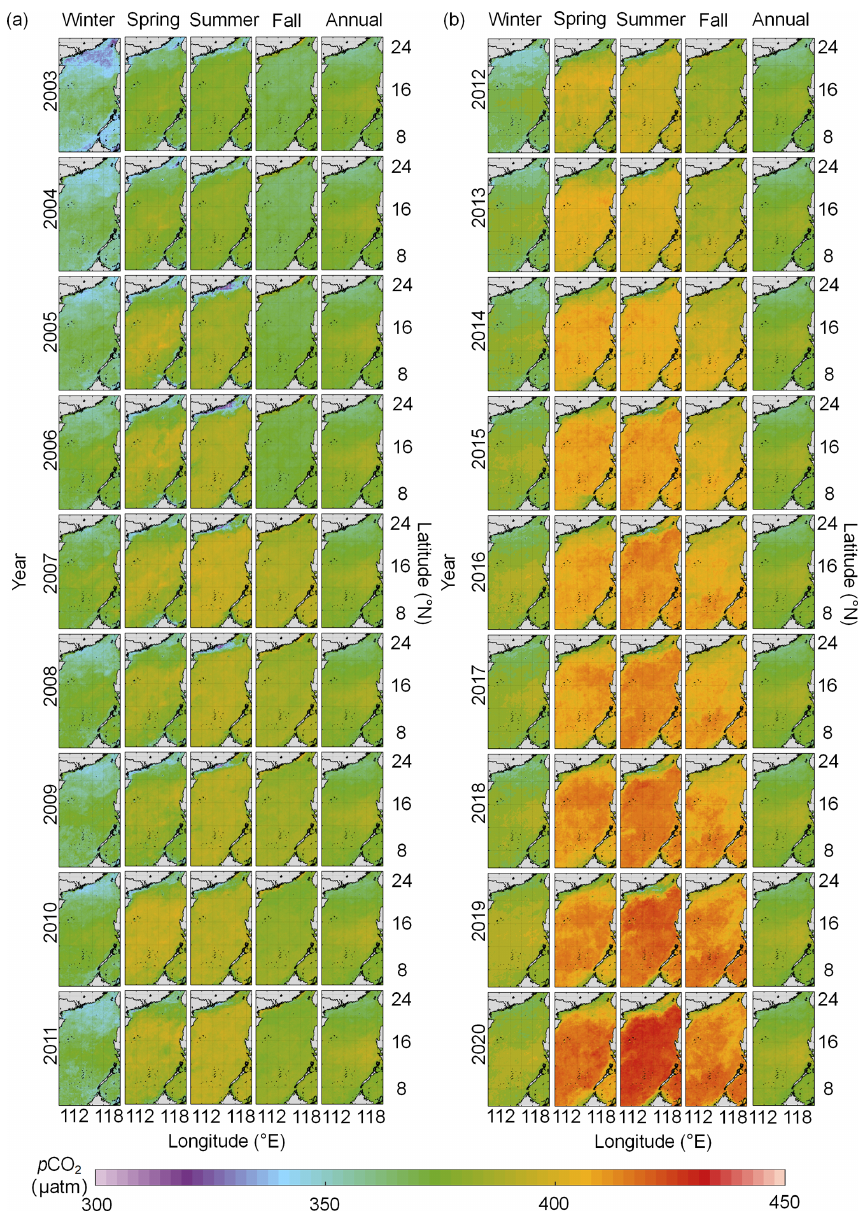
Figure 6. Reconstructed seasonal and annual p CO 2 fields in the South China Sea from 2003 to 2020 ( a , 2003–2011; b , 2012–2020).